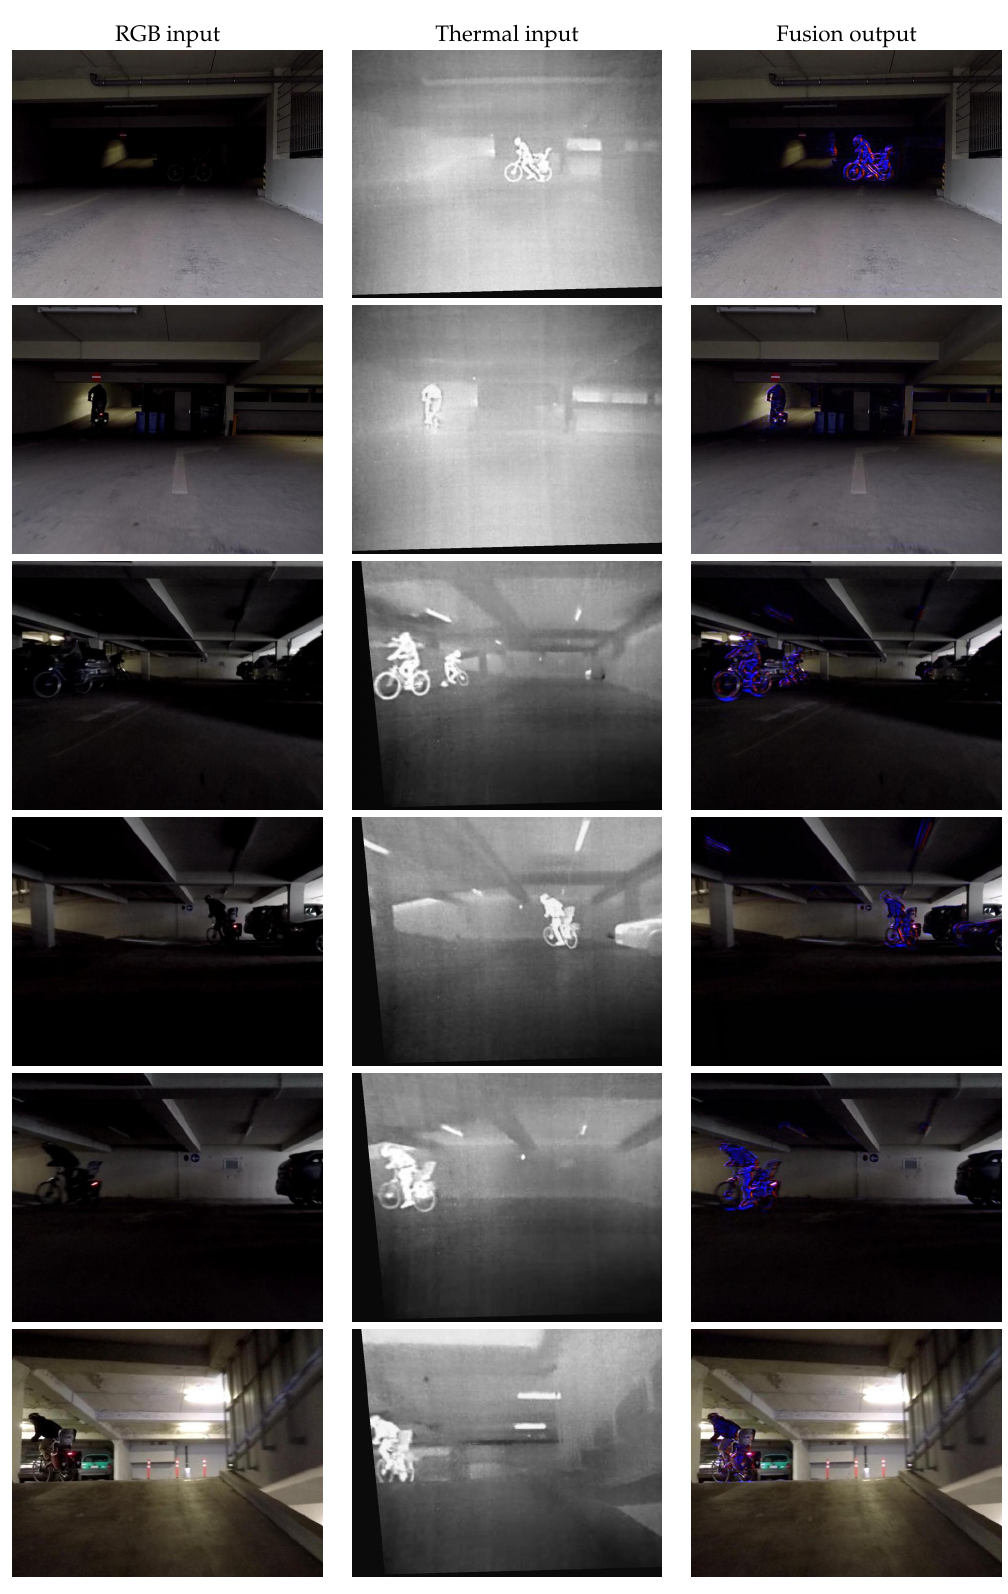
Figure 6. Cropped frame samples from our own sequence recorded in a parking lot using a pair of GoPro and FLIR